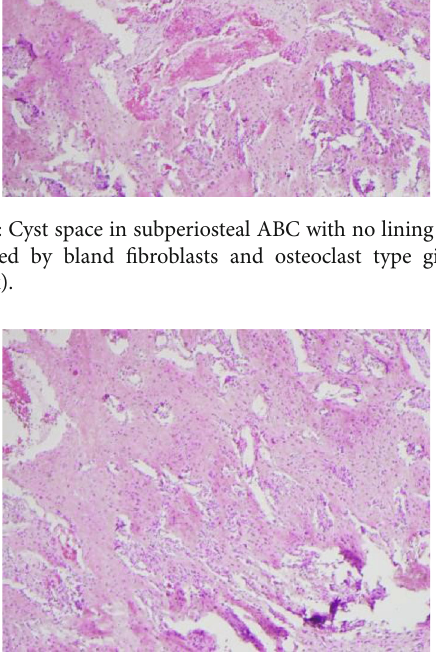
Figure 3: Low-power view demonstrating extensive woven bone formation associated with subperiosteal ABC (H&E, 4x).